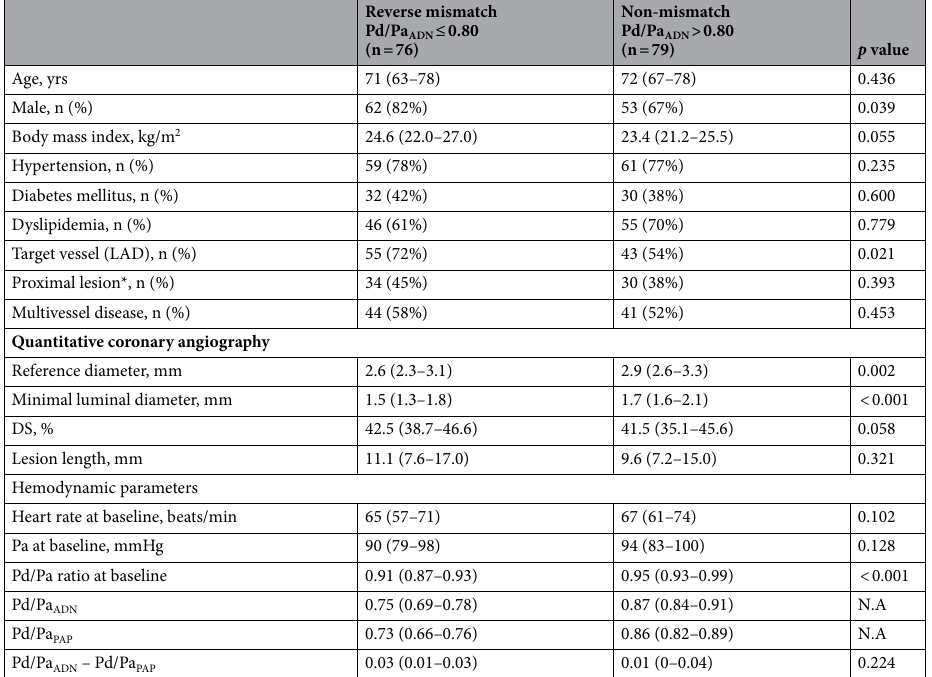
Table 4. Comparion clinical and lesion characteristics in vessels with DS ≤ 50% between the anatomical– functional reverse mismatch and non-reverse mismatch groups. Values are expressed as medians (interquartile ranges) or frequencies (percentages). The reverse mismatch was defined as DS ≤ 50% and Pd/Pa ADN ≤ 0.80, and the non-reverse mismatch as DS ≤ 50% and Pd/Pa ADN > 0.80. *Proximal location was defined as Syntax segments 1, 5, 6, and 11. DS diameter stenosis, LAD left anterior descending coronary artery, Pa aortic pressure, Pd/Pa distal-to-aortic pressure ratio, Pd/Pa ADN distal-to-aortic pressure ratio associated with adenosine, Pd/Pa ADN distal-to-aortic pressure ratio associated with papaverine.